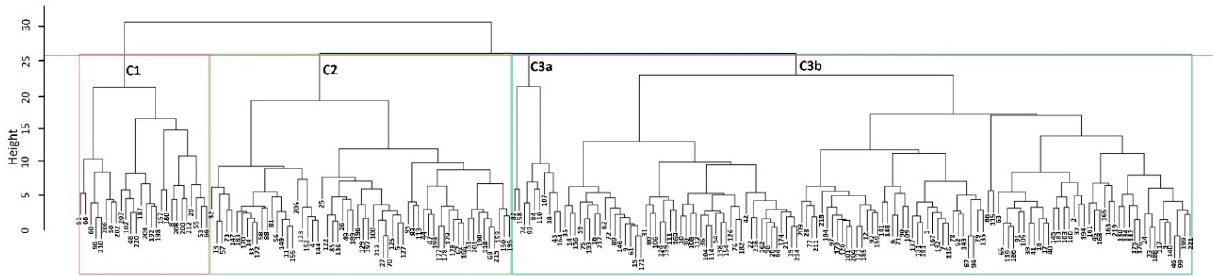
Figure 6. Ward cluster analysis of the 221 pomegranate genotypes based on morphological and pomological traits using Euclidean distances.